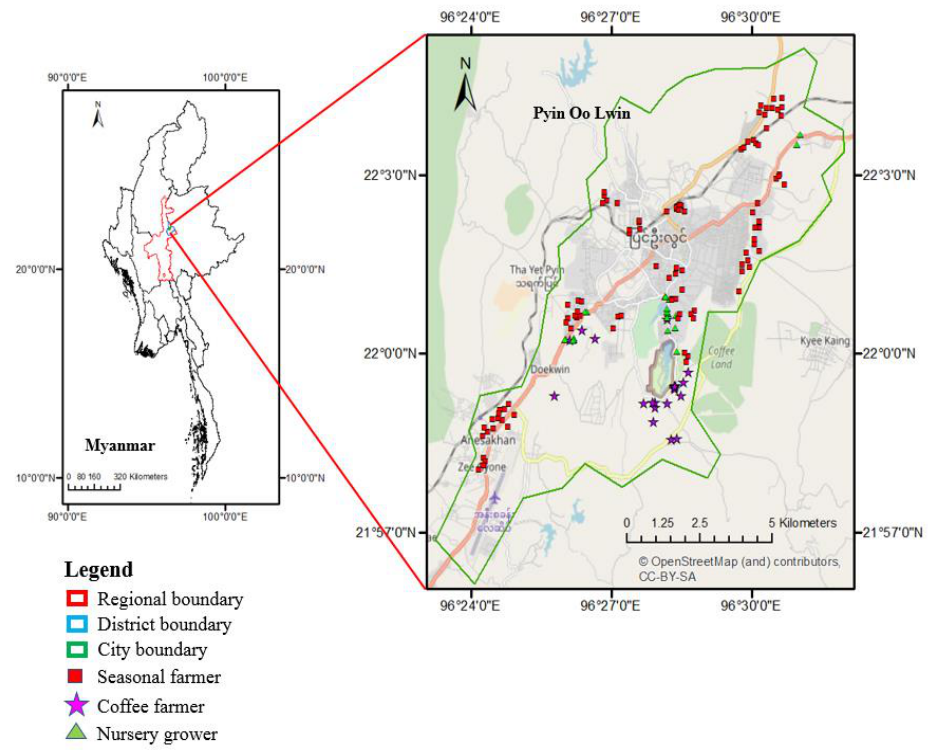
Figure 1. Location of Pyin Oo Lwin and the surveyed farms.